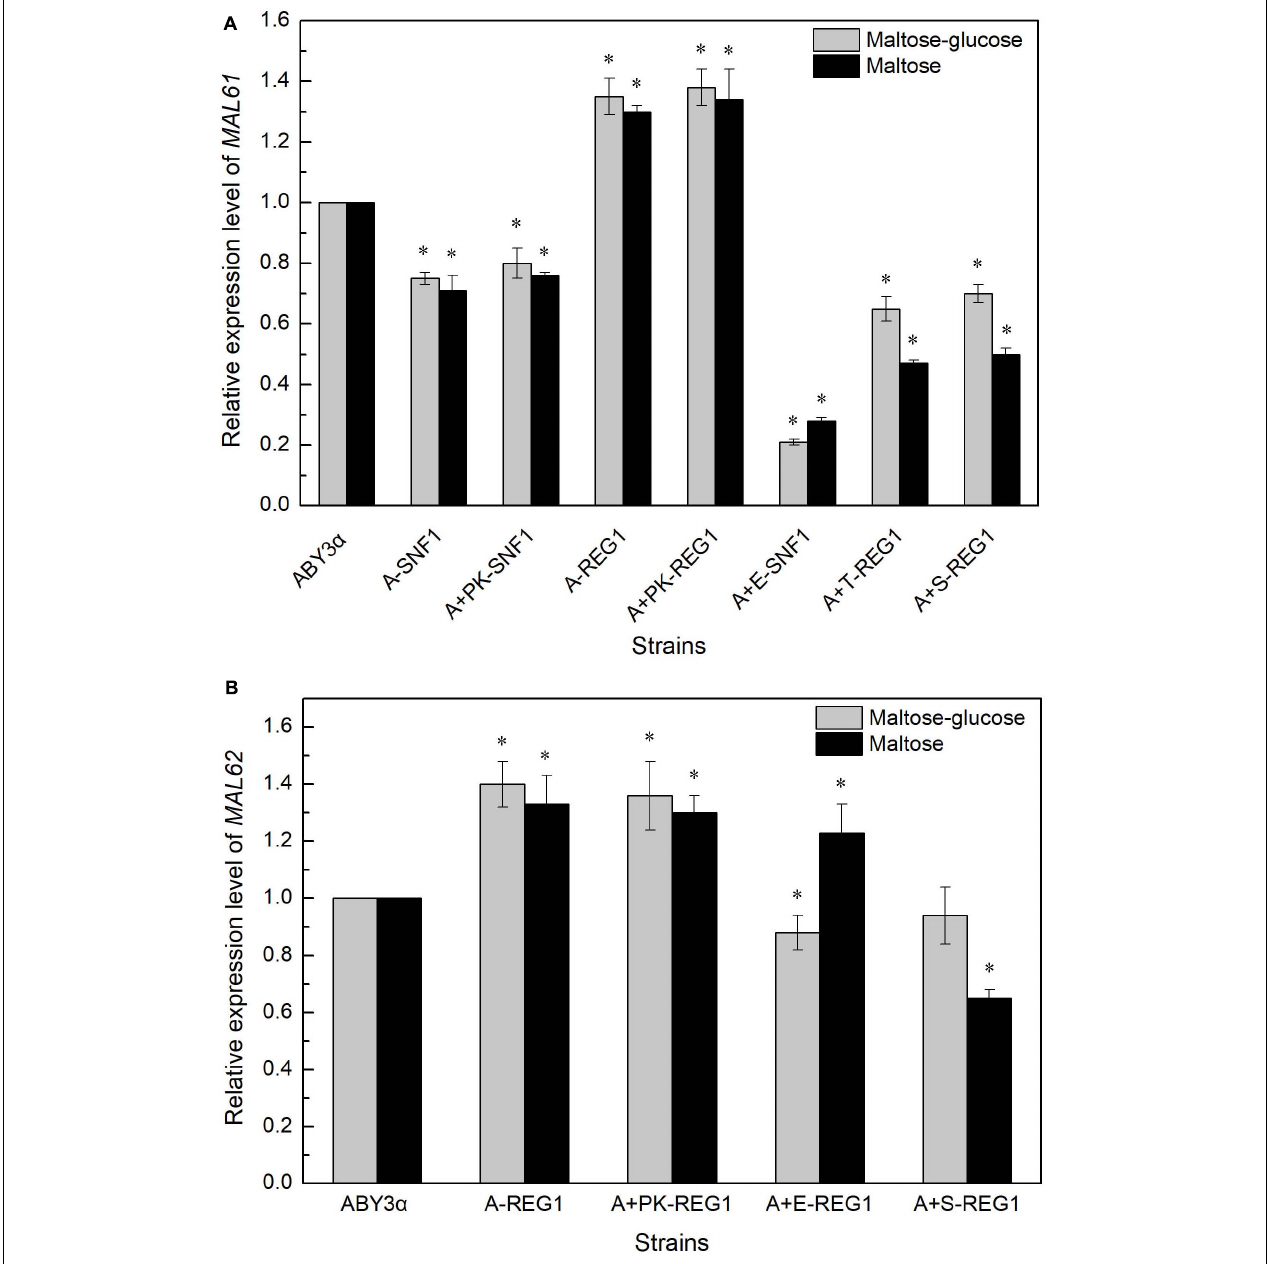
FIGURE 6 | Expression levels of (A) MALx1 and (B) MALx2 in the gene-combination mutants. 2 g fresh yeast was cultured in the LSMLD media and cultures were sampled at 30 min. The expression levels of genes (A) MAL61 and (B) MAL62 were tested using qRT-PCR. ABY3 α , the parental strain; A-SNF1, the SNF1 -deleted mutant; A+PK-SNF1, the SNF1 -deleted mutant carrying the vector Yep-PK; A-REG1, the REG1 -deleted mutant; A+PK-REG1, the REG1 -deleted mutant carrying the vector Yep-PK; A+E-SNF1, the SNF1 -deleted mutant carrying ELM1 overexpression; A+E-REG1, the REG1 -deleted mutant carrying ELM1 overexpression; A+T-REG1, the REG1 -deleted mutant carrying TOS3 overexpression; A+S-REG1, the REG1 -deleted mutant carrying SAK1 overexpression. Significant differences of the transformants to the parental strain were confirmed at ∗ P < 0.05.